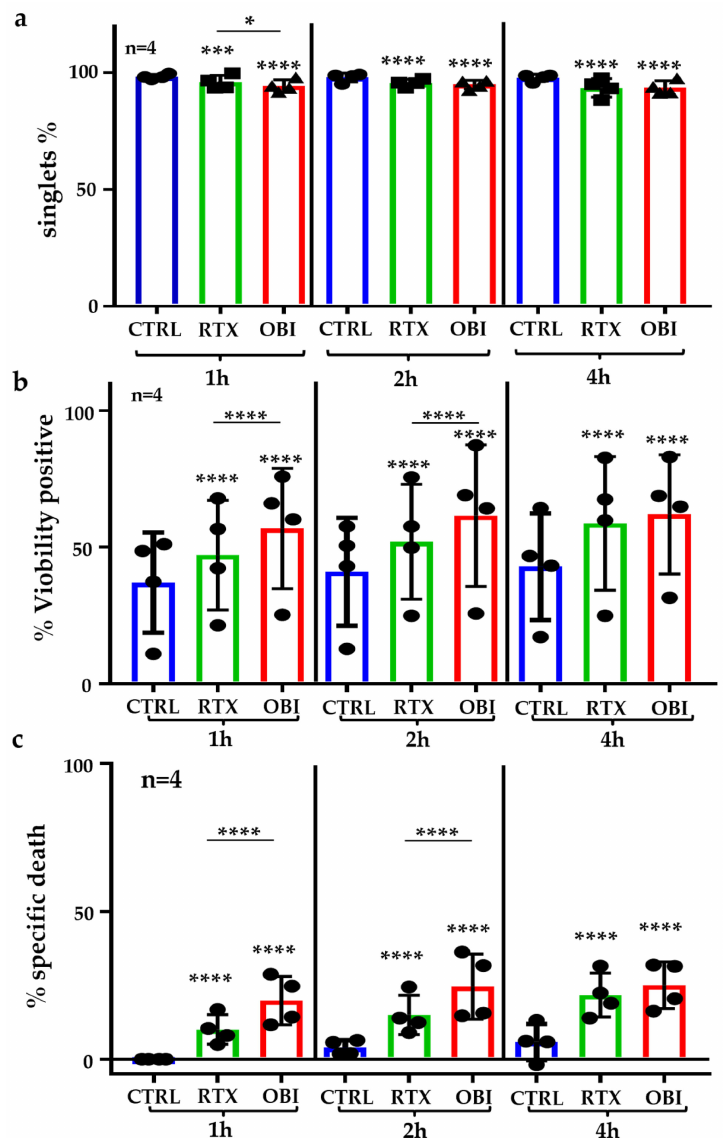
Figure 5. RTX and OBI induced cell aggregation and direct cell death on PBMCs from B-CLL patients. B-CLL PBMCs (1 million/mL) were thawed and directly incubated with RTX or OBI (10 µ g/mL) for the indicated times. Next, cells were directly analyzed by FACs with neither washing nor centrifugation steps. ( a ) The percentage of singlets were quantified by FACs as described in Figure S1b,c. After treatment, cells were washed and stained with an CD19 mAb to select B cells and Viobility TM 405/452 to stain dead events. Cells were washed and analyzed by FACs using Beckman Coulter Gallios 3 Lasers. The graphs display the raw percentage of viability ( b ) or the treatment- specific cell death, which was obtained after subtracting the percentage of cell death from the control 1 h after incubation ( c ). Each graph represents mean +/ − SD of 4 patients with measurements performed in duplicate. * p < 0.05, *** p < 0.001, **** p < 0.0001; Tukey’s multiple comparisons test compared to control or as depicted in the